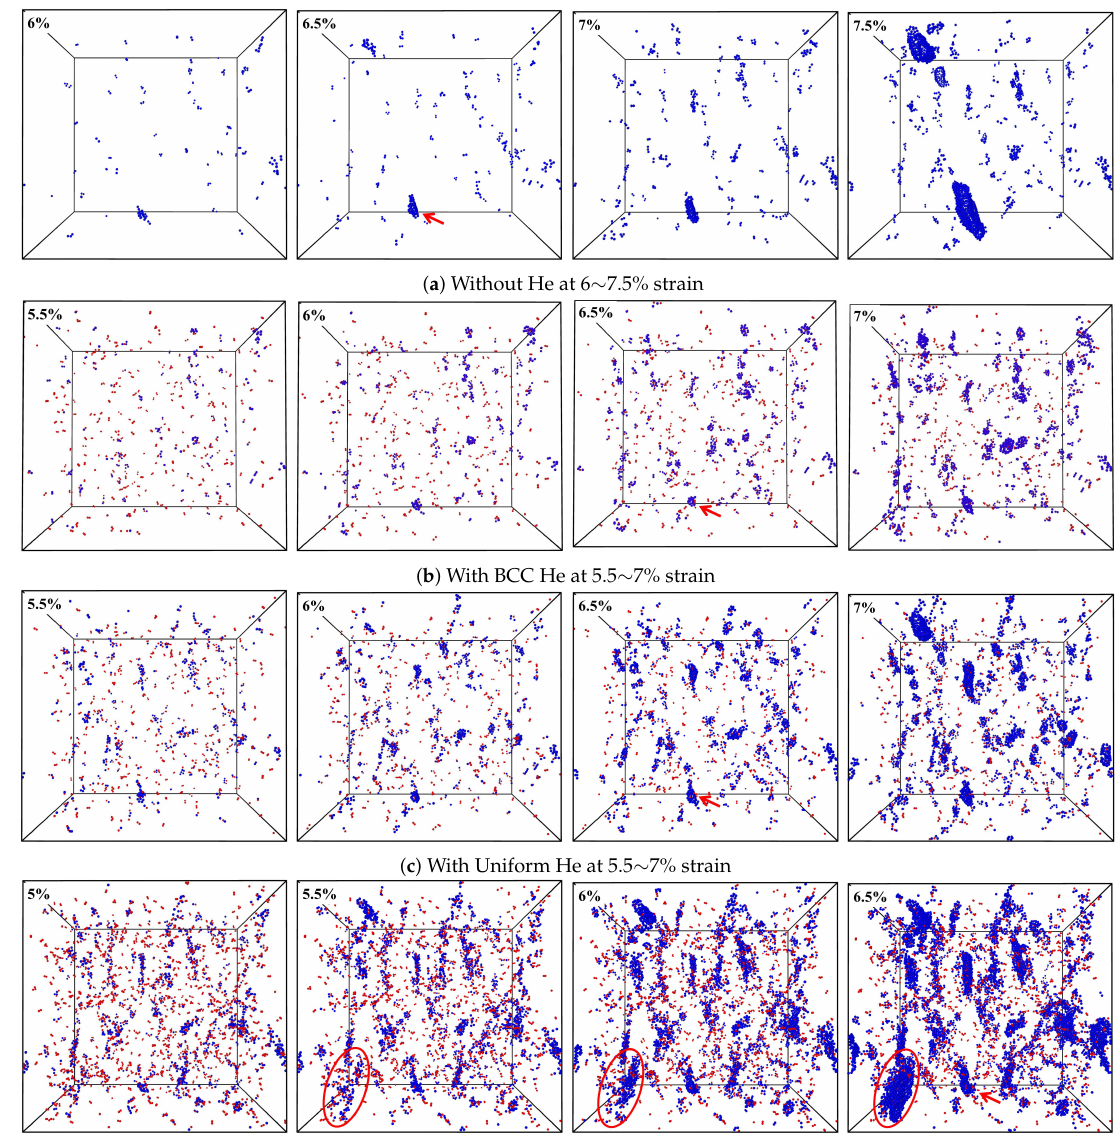
Figure 8. The evolution process of crack in model ( a ) without He at 6 ∼ 7.5% strain; ( b ) with 0.5% BCC He at 5.5 ∼ 7% strain; ( c ) with 0.5% uniform He at 5.5 ∼ 7% strain; ( d ) with 0.5% GB He at 5 ∼ 6.5%